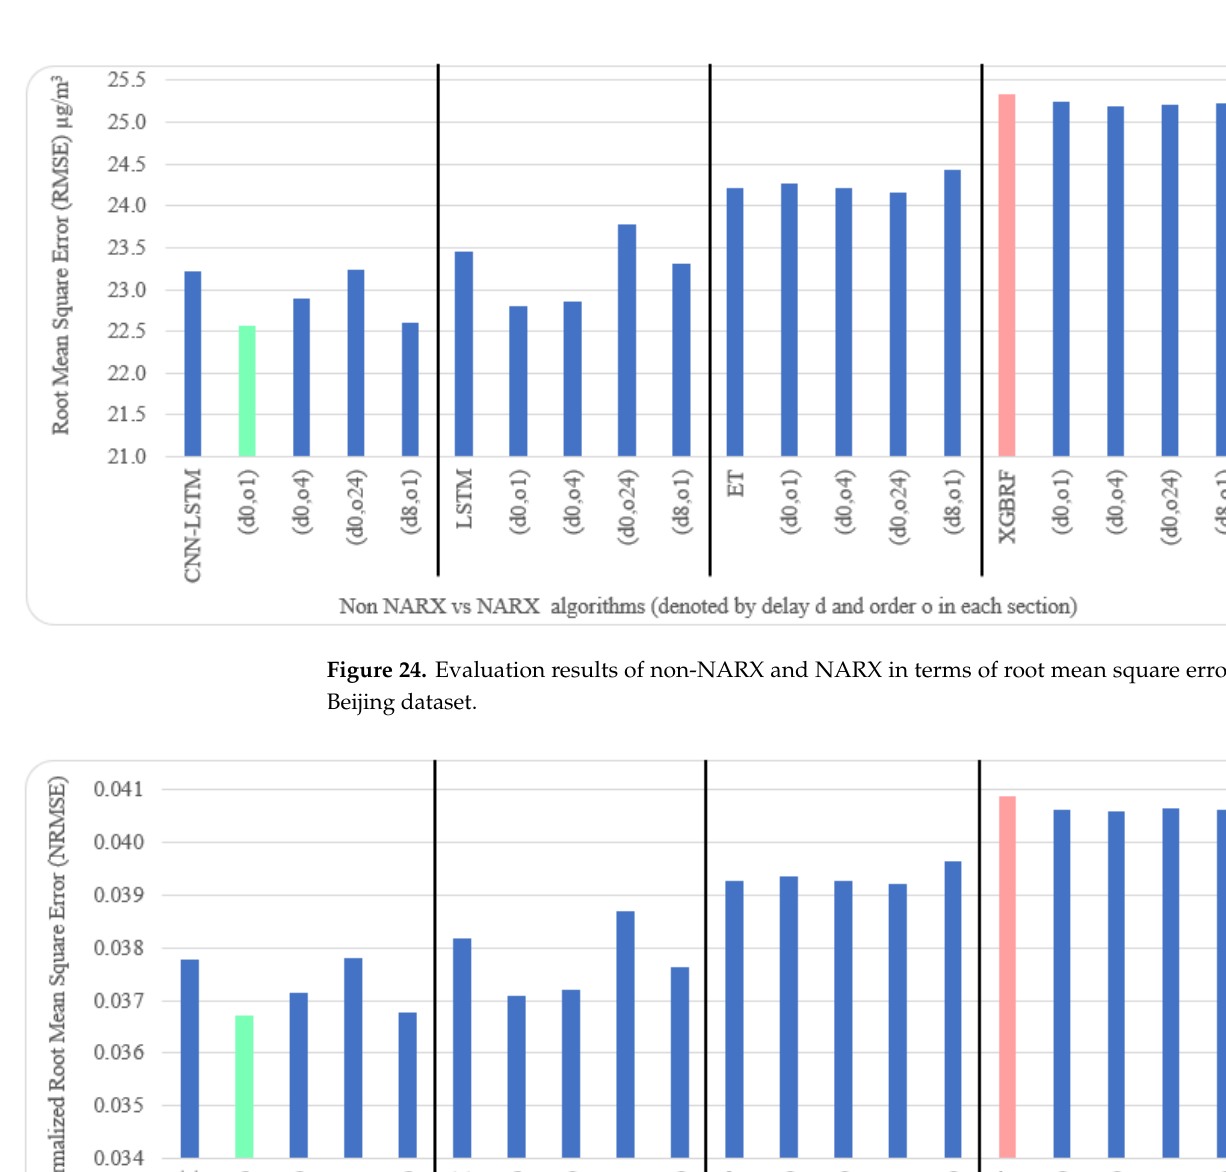
Figure 23. Evaluation results of non-NARX and NARX in terms of index of agreement for the Beijing dataset.